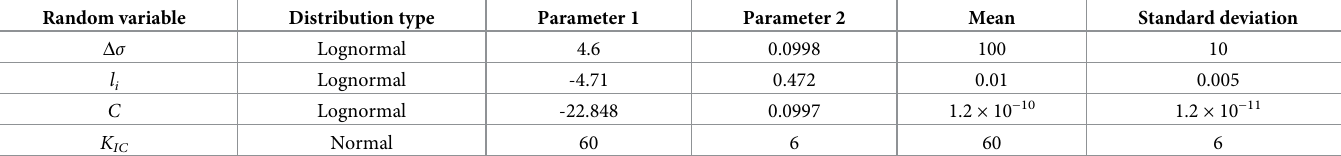
Table 2. Probabilistic characteristics of the variables in example 2. Random